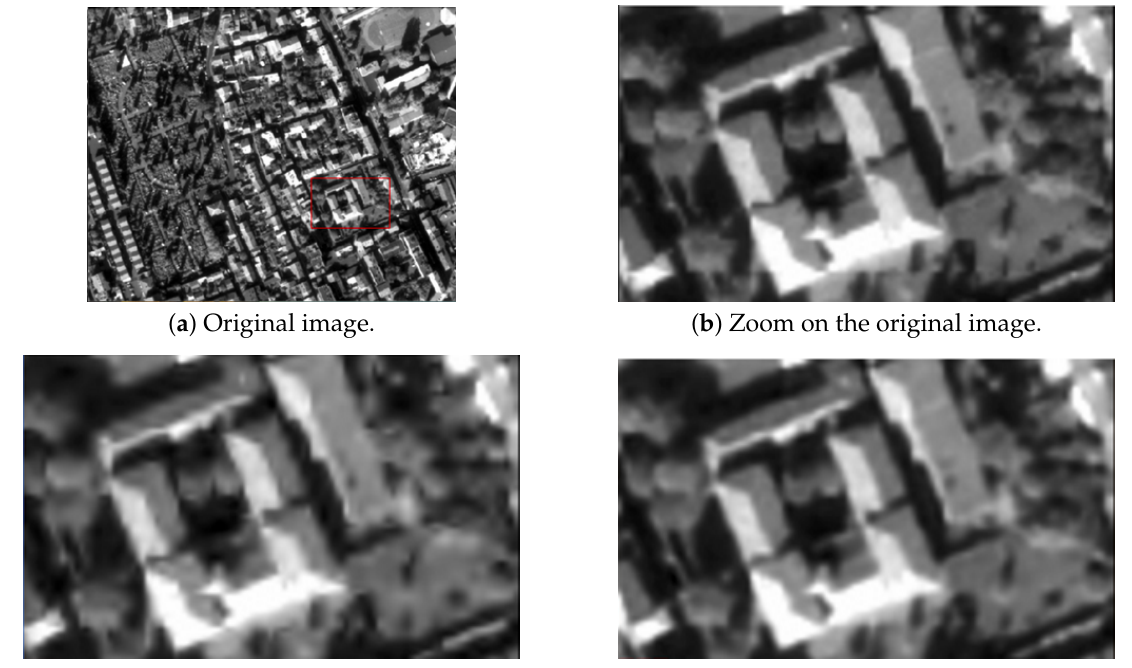
( c ) Zoom on the CCSDS compressed image. ( d ) Zoom on the end-to-end compressed image. Figure 7. Subjective image quality analysis (R = 1.15 bits/pixel). For medium luminances, far less artifacts, such as blurring and flattened effects are observed. In particular, the building edges are sharper. The same is true for low luminances, corresponding to shaded areas: the ground markings are sharp and less flatened areas are observed. As shown in Figure 8, for a higher rate of 1.66 bits/pixel, the two reconstructed images are very close. However, the image obtained through learning compression remains closest to the original one, especially in shaded areas.